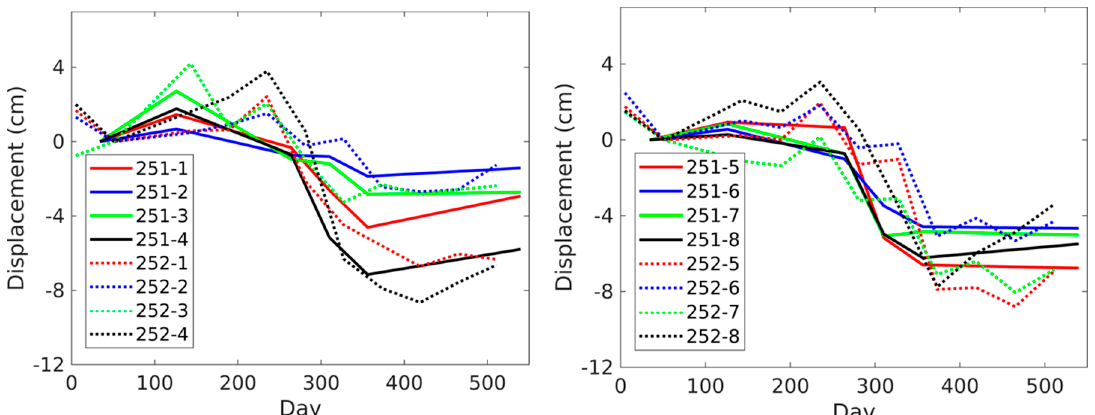
Figure 8. Plot of deformation for the eight selected points. Each pair of the same-color solid and dotted lines represent graphs of one selected point over path 251 and 252, respectively. The x-coordinate shows days passed since 1 September 2009.